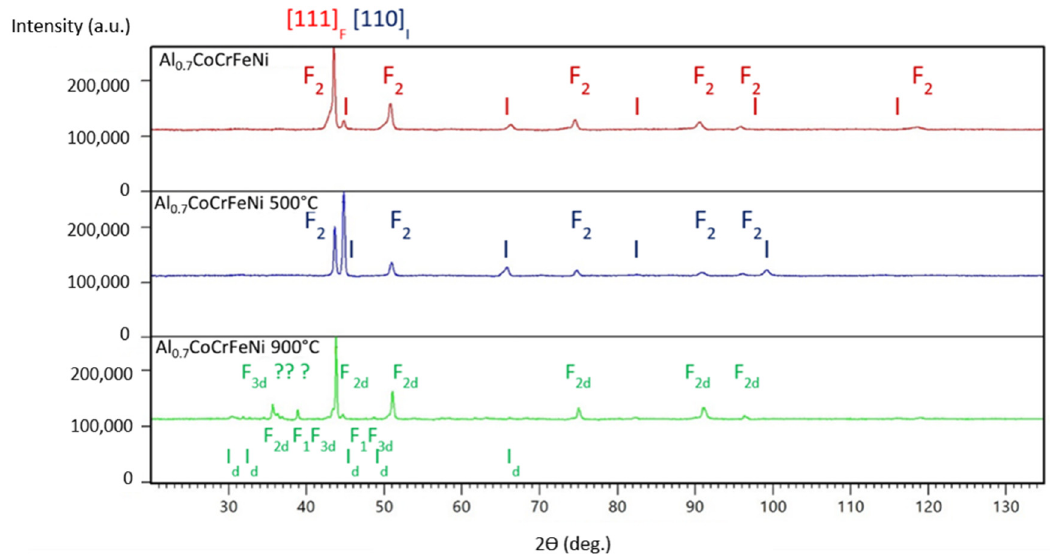
Figure 4. X-ray diagrams of as-cast Al 0.7 CoCrFeNi samples and those annealed at different temperatures. The identified phases have been marked according to the graphic symbols described in Table 2. The directions of the mechanical textures are shown at the top of the diagram set.